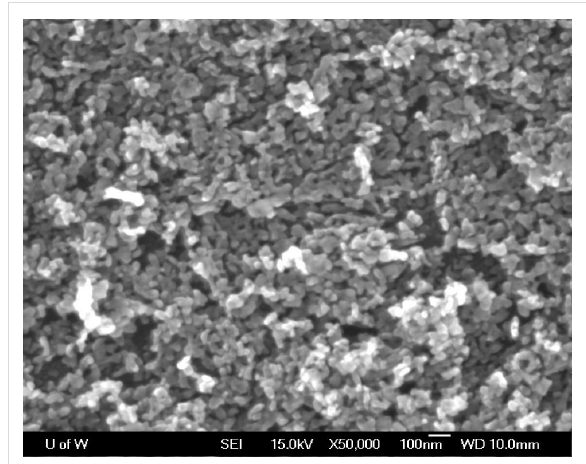
Figure 1: SEM image of a ZnO-seeded ITO substrate annealed at 500 °C for 30 min.